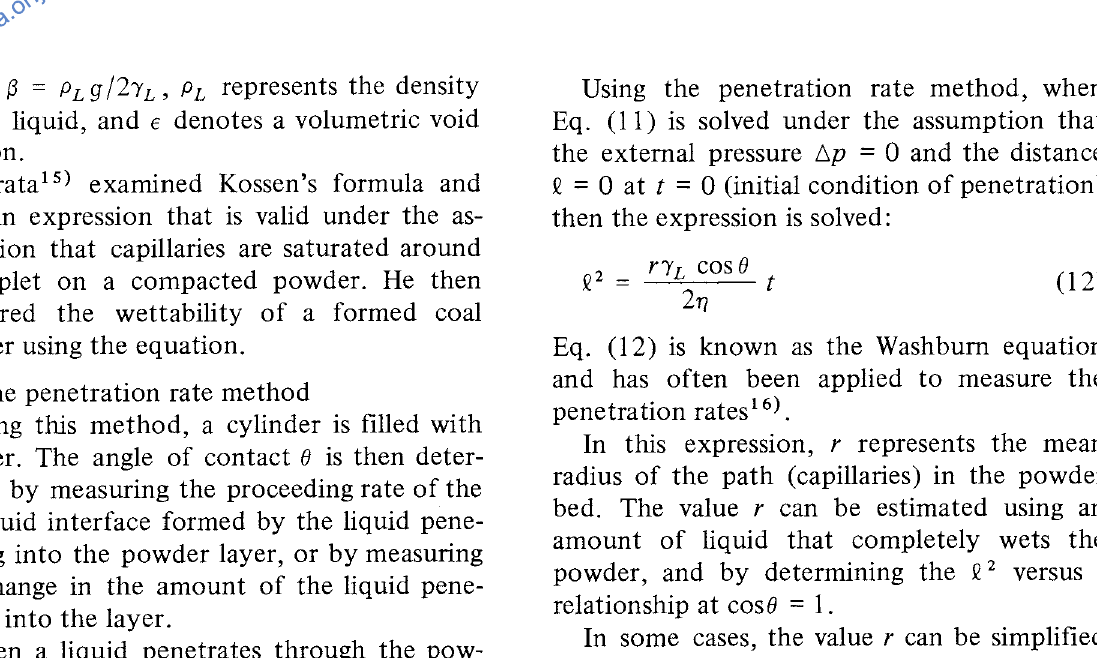
Fig. 4 Apparatus for measuring the penetration rate used by equilibration